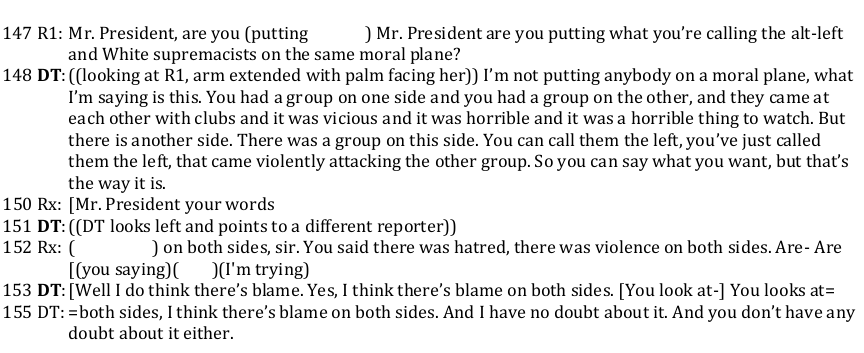
Figure 14. Transcript excerpt 147–155.